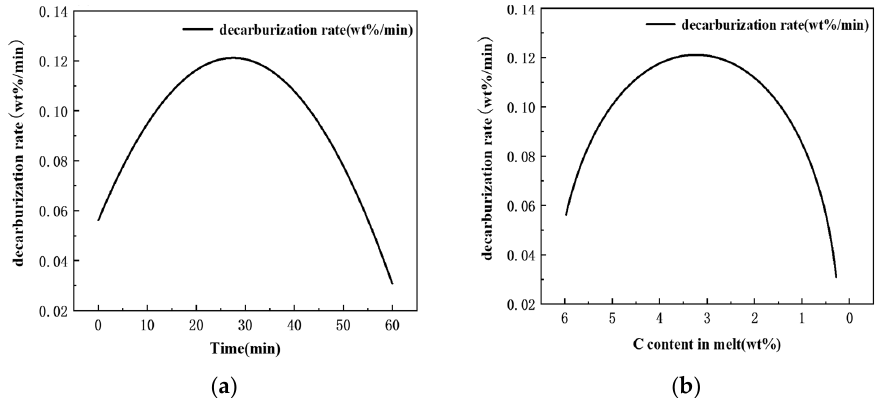
Figure 8. Variation in carbon content with time in melt when blowing pure O 2 : ( a ) variation in C content in melt; ( b ) fitted curve of variation in C content in melt.